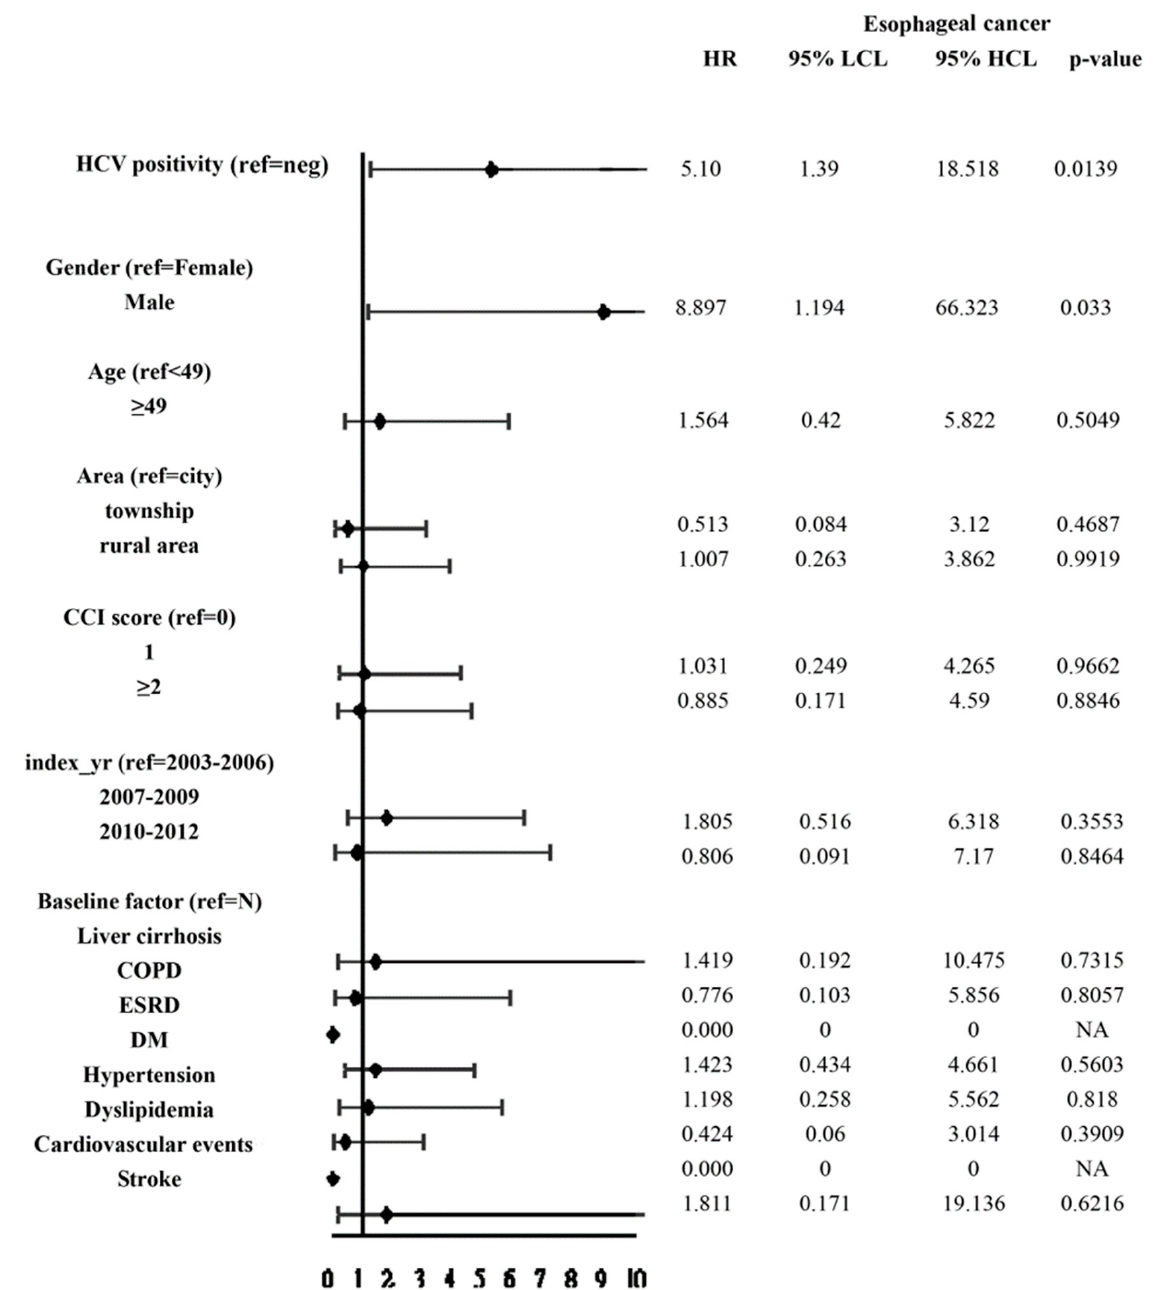
Figure 3. Forest plot of factors associated with incident esophageal cancers in the two TNHIRD cohorts, including HCV- positive and HCV-negative cohorts. neg: Negative; HR: hazards ratio; CI: confidence interval; LCL: lower confidence limit; HCL: higher confidence limit; HCV: hepatitis C virus; COPD: Chronic obstructive pulmonary disease; ESRD: end stage renal disease; DM: diabetes.